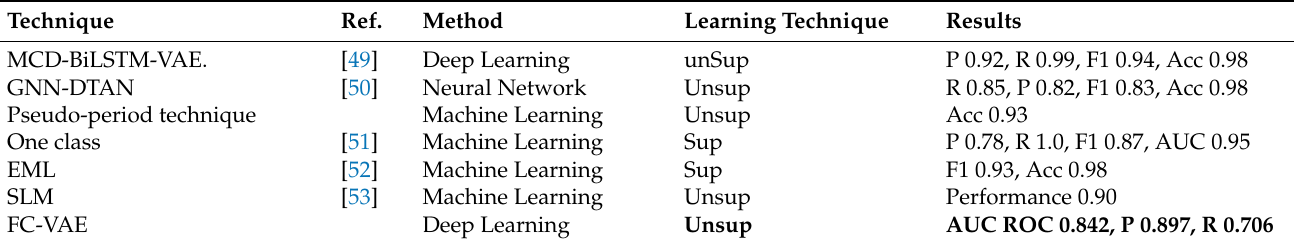
Table 2. Comparison of proposed FC-VAE with state-of-the-art techniques.